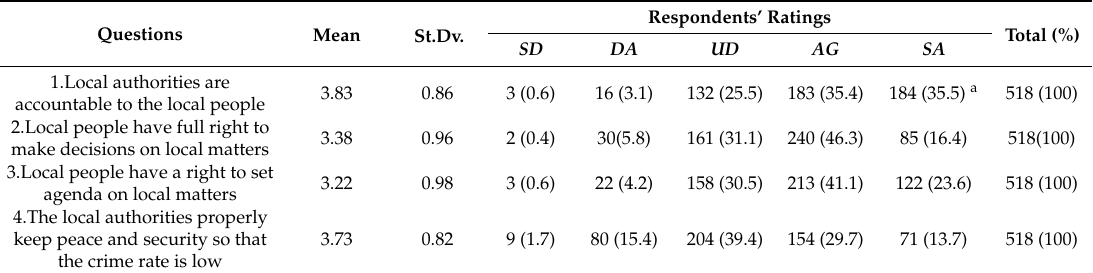
Table 2. Respondents’ views of power relations at local level (N =